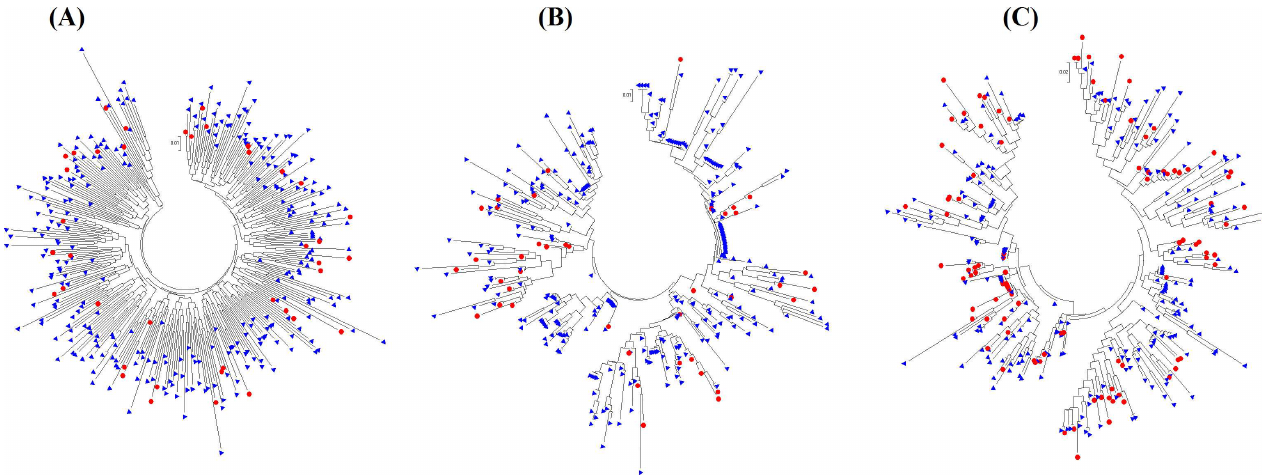
Fig 1. Phylogenetic trees based on amino acid sequences for (A) Historic full-length Nef, (B) Historic R2, and (C) Modern R2. Each blue trianglerepresents a full-lengthNef sequence or an R2 subsequence where the most stable R2 structure fell into the dominant cluster; each red circle, into the alternative